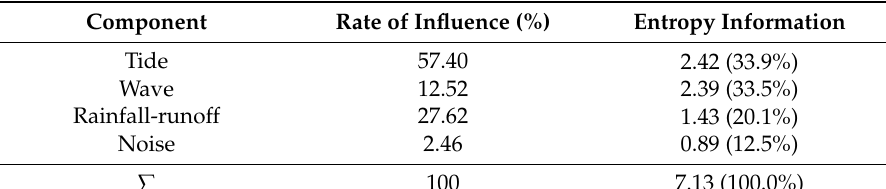
Table 1. The rate of influence for each component.